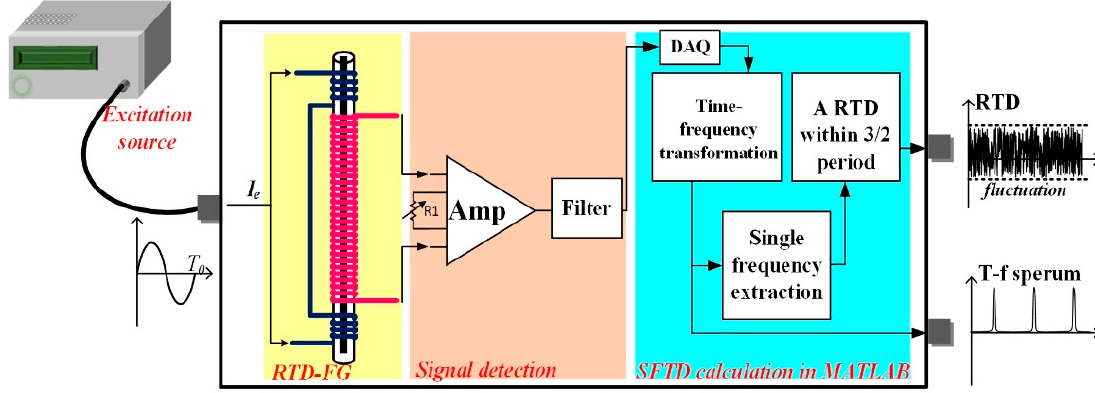
Figure 6. RTD fluxgate sensor system with single-frequency time difference (SFTD) method. DAQ: data acquisition.